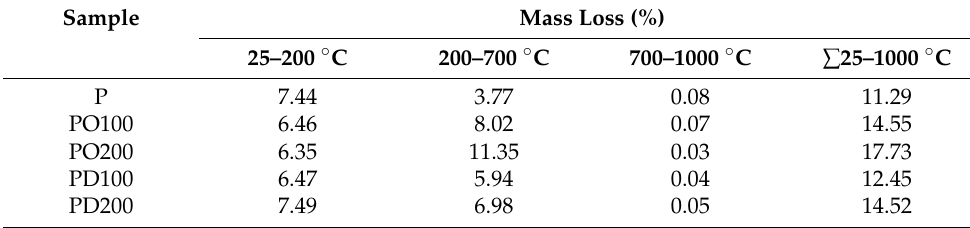
Figure 2. DSC analysis of starting material—P and composites PO100, PO200, PD100 and PD200. Table 1. Mass loss (%) from TGA curves for starting material-P and Based on the results given in Table 1 and TGA curves (not shown), for P, a contin- uous mass loss in the temperature range of 25–1000 ° C is observed, and the total mass